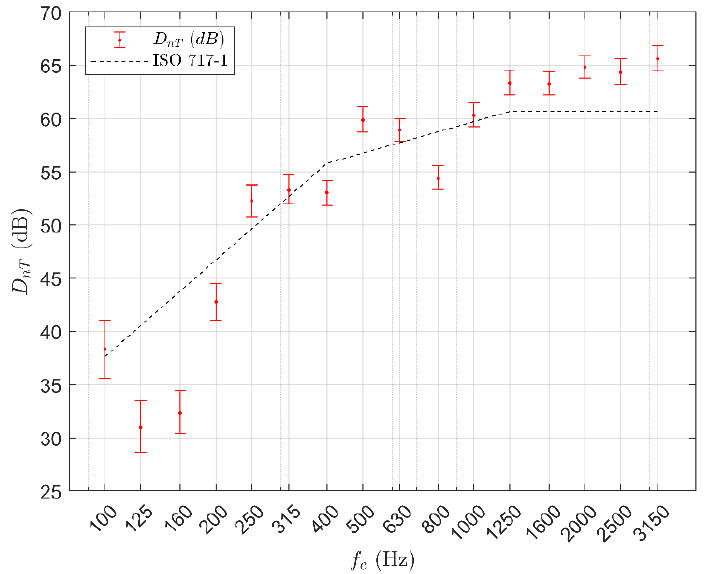
Figure 4. Standardized level difference of the Stbd Vip Cabin—Engine Room partition and reference values according to ISO 717-1:2020 [24].